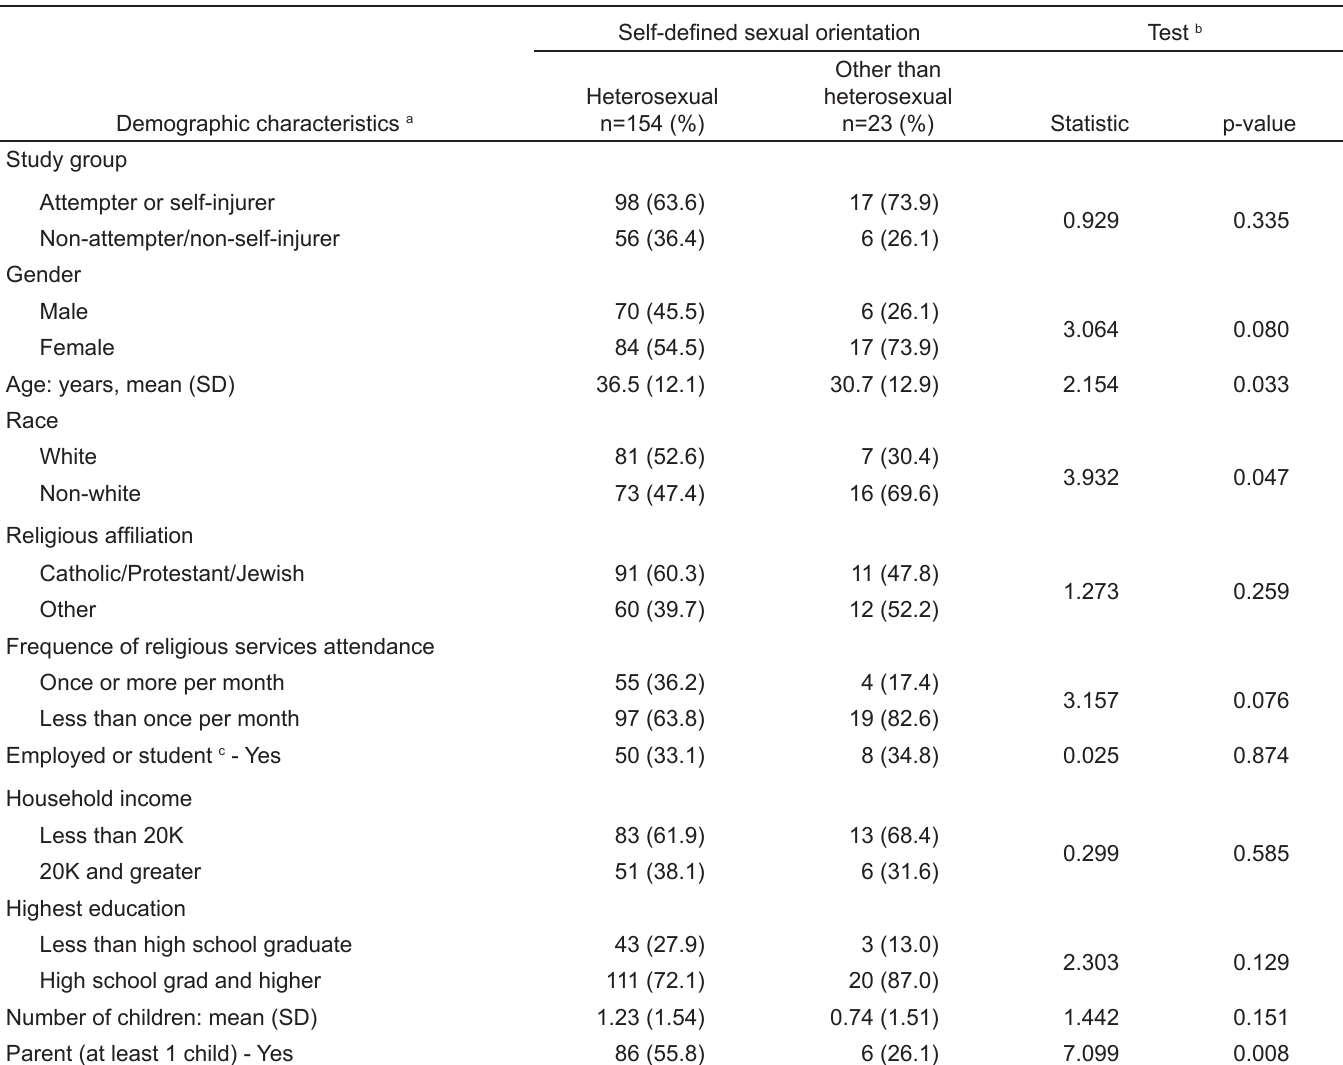
Table 1. Demographic characteristics of participants in study of self-defined sexual